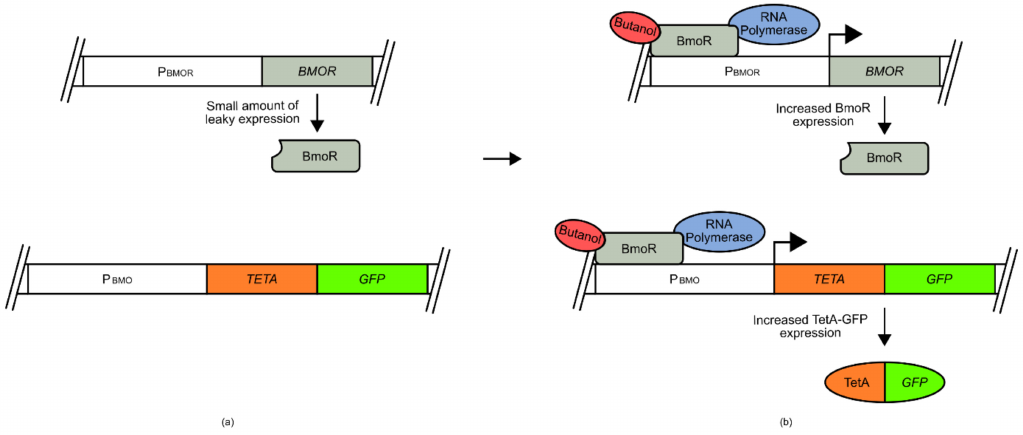
Figure 2. Butanol biosensor developed for use in E. coli. P BMOR is upstream of the